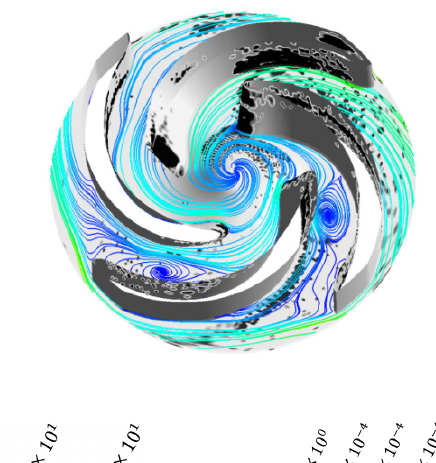
Figure 13. Velocity streamlines and wear in the impeller.